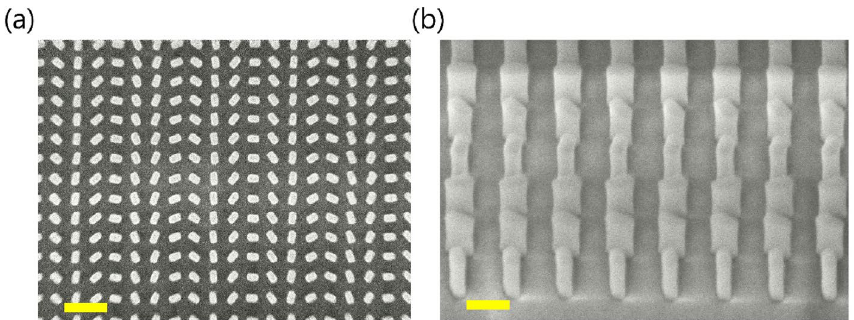
400 nm. ( b ) Tilted‑view (45°) of a portion of the metalens. Scale bar =